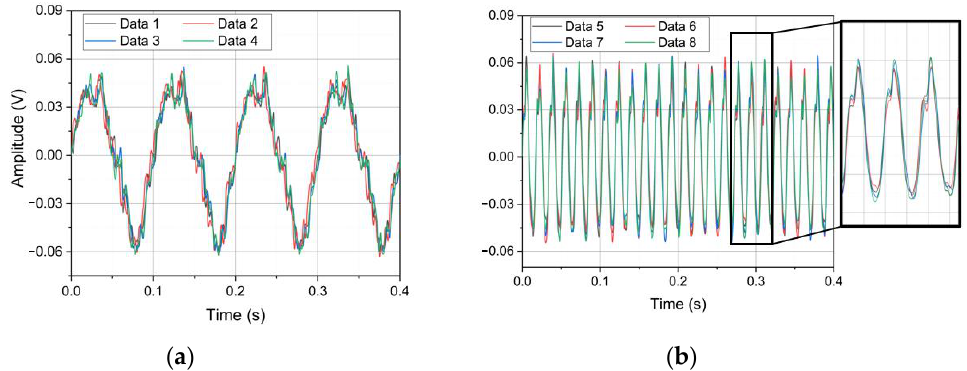
Figure 9. ( a ) Random four signal segments at 10 Hz; ( b ) Random four signal segments at 60 Hz.